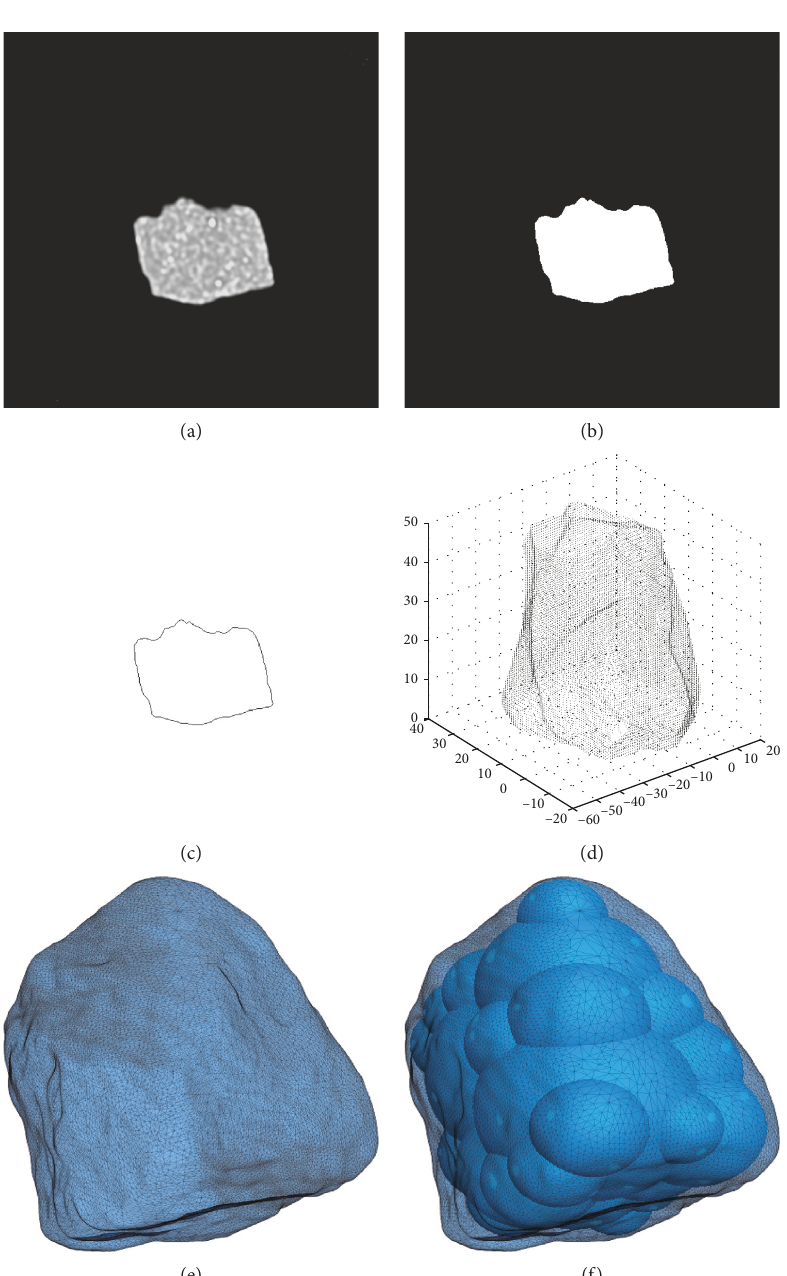
Figure 4: The process of particle shape reconstruction. (a) Sliced image. (b) Binarized image. (c) Grain contour. (d) Surface clouds. (e) Triangular mesh. (f) Clump template.